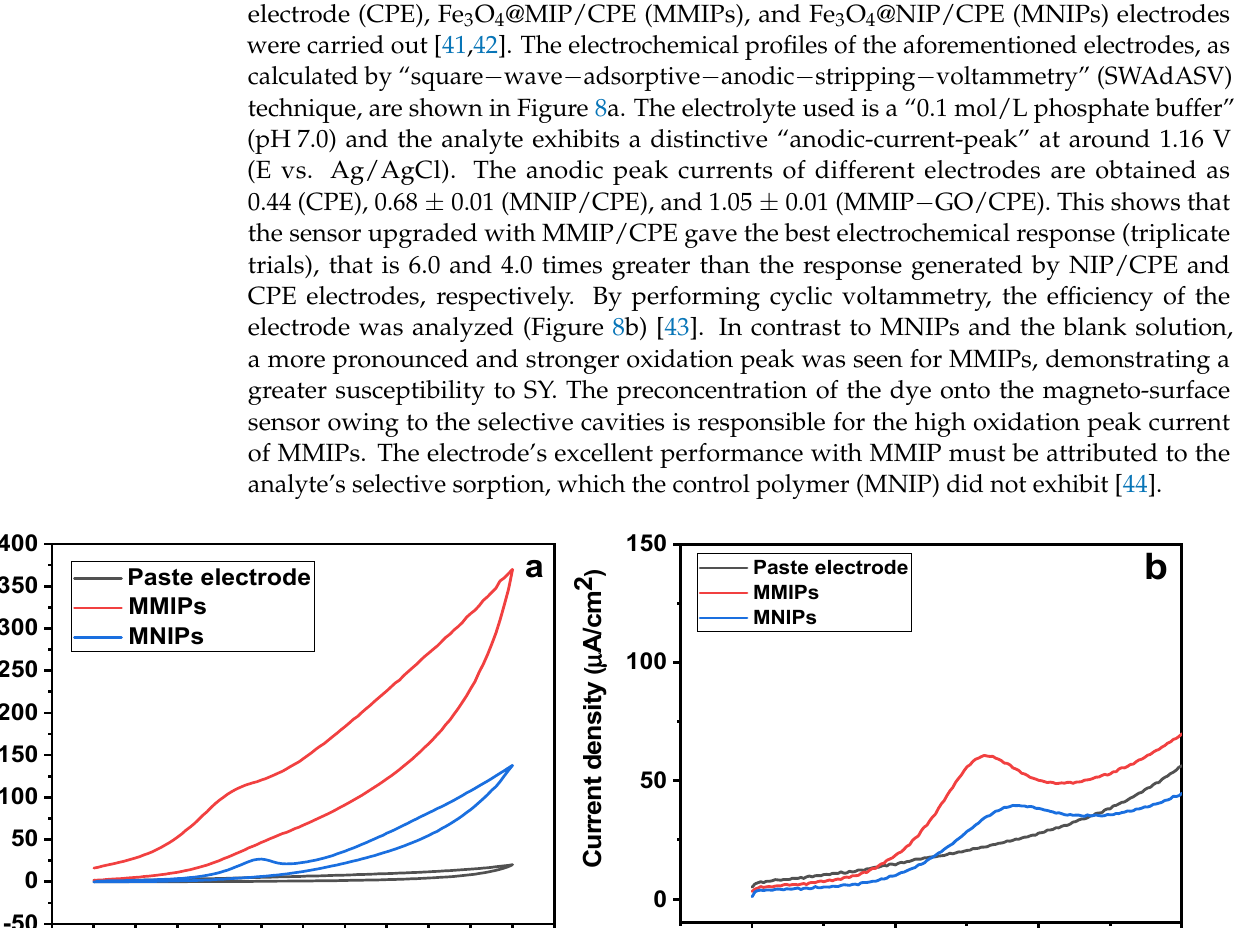
Figure 7. Isotherm studies ( a ) Freundlich Isotherm ( b ) Temkin Isotherm ( c ) Langmuir isotherm (linear) ( d ) Langmuir isotherm.